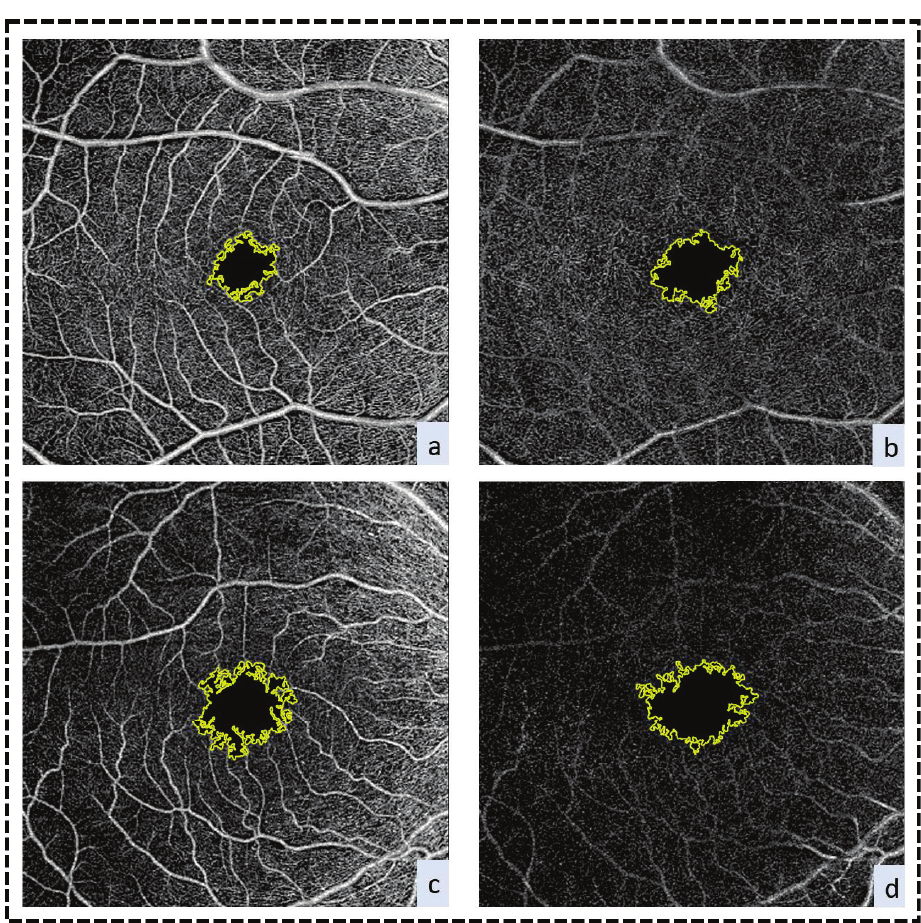
Figure 1. FAZ enlargement. ( a ) SCP for a normal subject, ( b ) DCP for a normal subject, ( c ) SCP for a diabetic patient, and ( d ) DCP for a diabetic